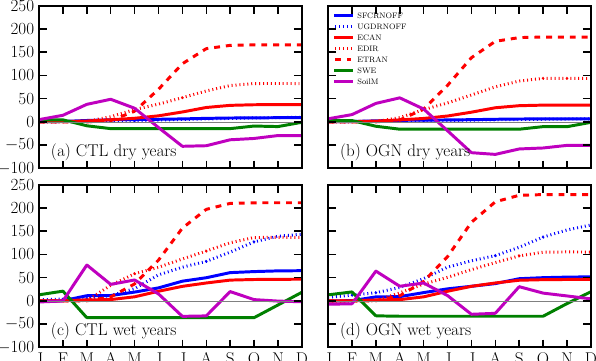
Figure 12. Water budgets: blue lines are accumulated surface runoff (mm), blue dots are accumulated underground runoff (mm), red lines are accumulated evaporation of intercepted water (mm), red dots are accumulated ground surface evaporation (mm), red dash lines are accumulated transpiration (mm), green lines are snow wa- ter equivalent changes (mm), purple lines are soil water content changes in the soil column (mm); (a, b) are averaged for 2002– 2003; (c, d) are averaged for